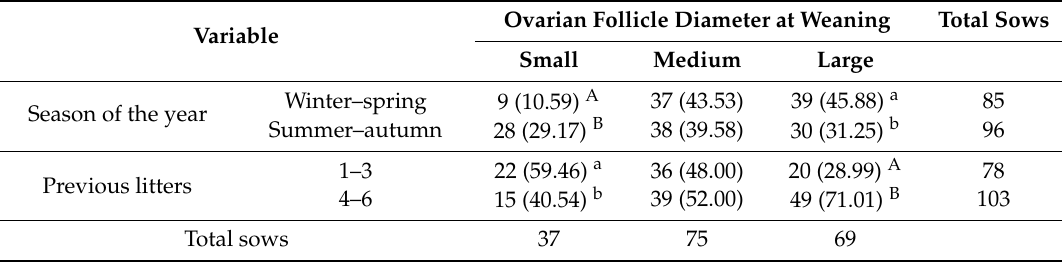
Table 2. Body condition and lactation length (mean ± SEM) at weaning in the sows showing small (0.20–0.30 cm), medium (0.31–0.39 cm), and large (0.40–1.00 cm) ovarian follicular diameter at weaning.